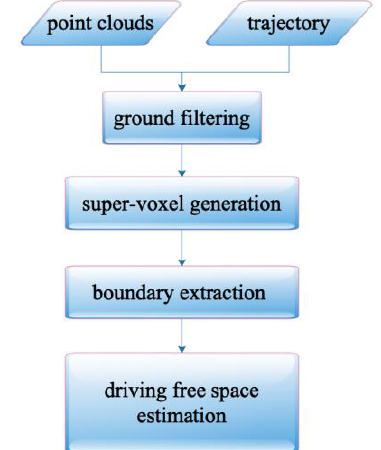
Figure 1. The workflow of the proposed